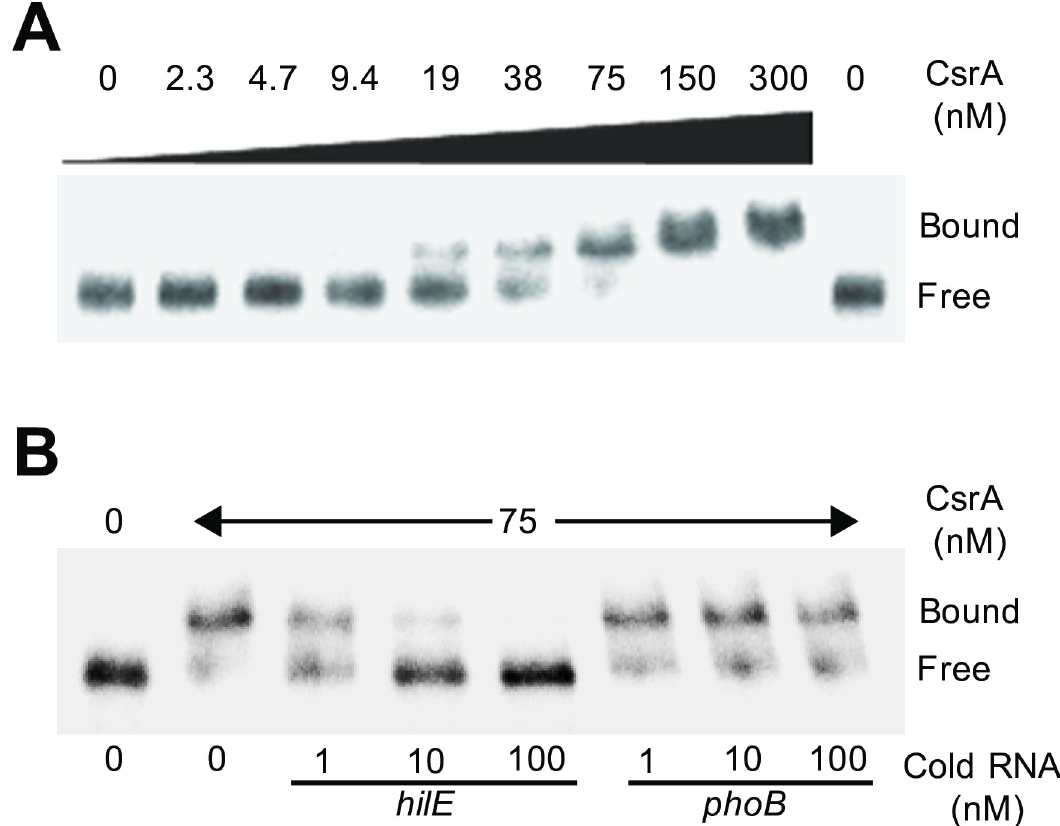
Fig 2. CsrA specifically interacts with the leader region of the hilE transcript. (A) CsrA binding to the hilE RNA was analyzed using EMSAs by incubating labeled hilE RNA (0.2 nM) with increasing concentrations of purified CsrA (0, 2.3, 4.7, 9.4, 19, 38, 75, 150 and 300 nM). Positions of bound and free RNA are marked. These experiments were performed three times and a representative gel is shown. (B) RNA competition experiment where labeled hilE RNA (0.2 nM) was combined with 1, 10 and 100 nM of unlabeled specific ( hilE ) or non-specific ( phoB ) competitor RNA and incubated with 0 and 75 nM of purified CsrA. Positions of bound and free RNA are marked. A representative gel from two independent assays is